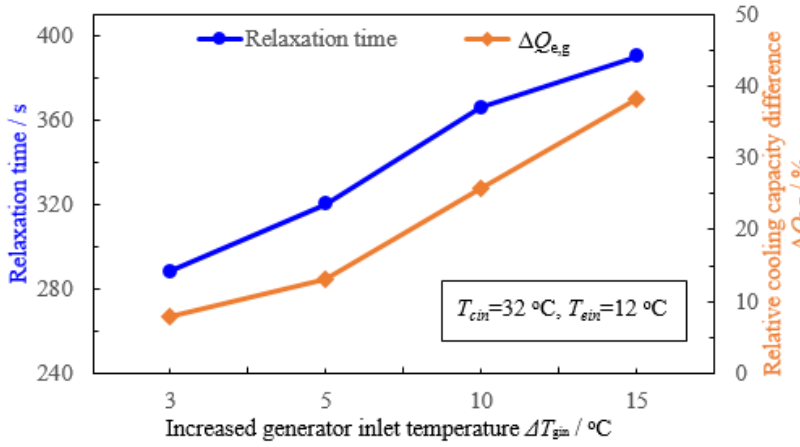
Figure 8. The effect of different ∆ T gin on the relaxation time and ∆ Q e , g .